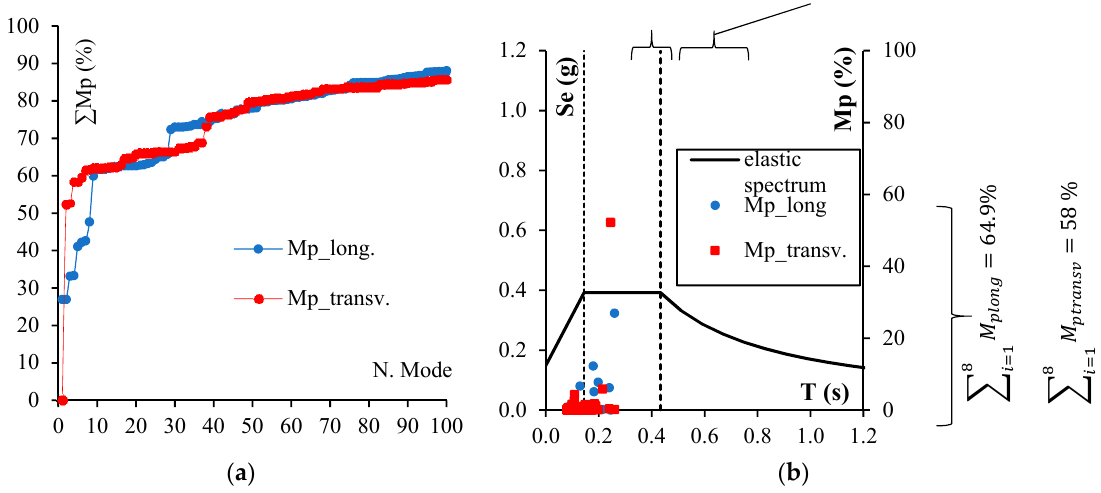
Figure 6. ( a ) Distribution of the modal participating mass ratio; ( b ) participating mass ratios associated to vibration periods.